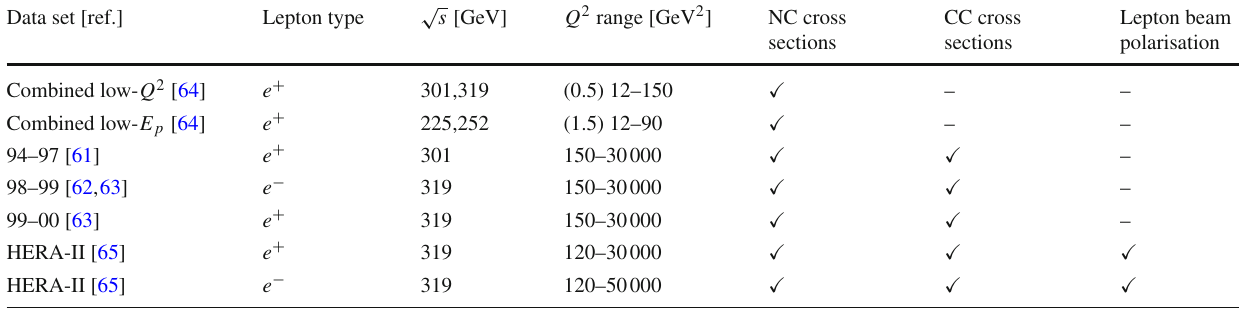
Table 3 Summary of the inclusive NC and CC DIS data sets. The The check-marks indicate the available measurements. The last col- √ s and the considered Q 2 lepton type, the ep centre-of-mass energy umn indicates cross sections determined with longitudinally polarised range are shown. The numbers in parenthesis show the whole kinematic leptons range of the data prior to applying the Q 2 cut specific for this analysis. Data set